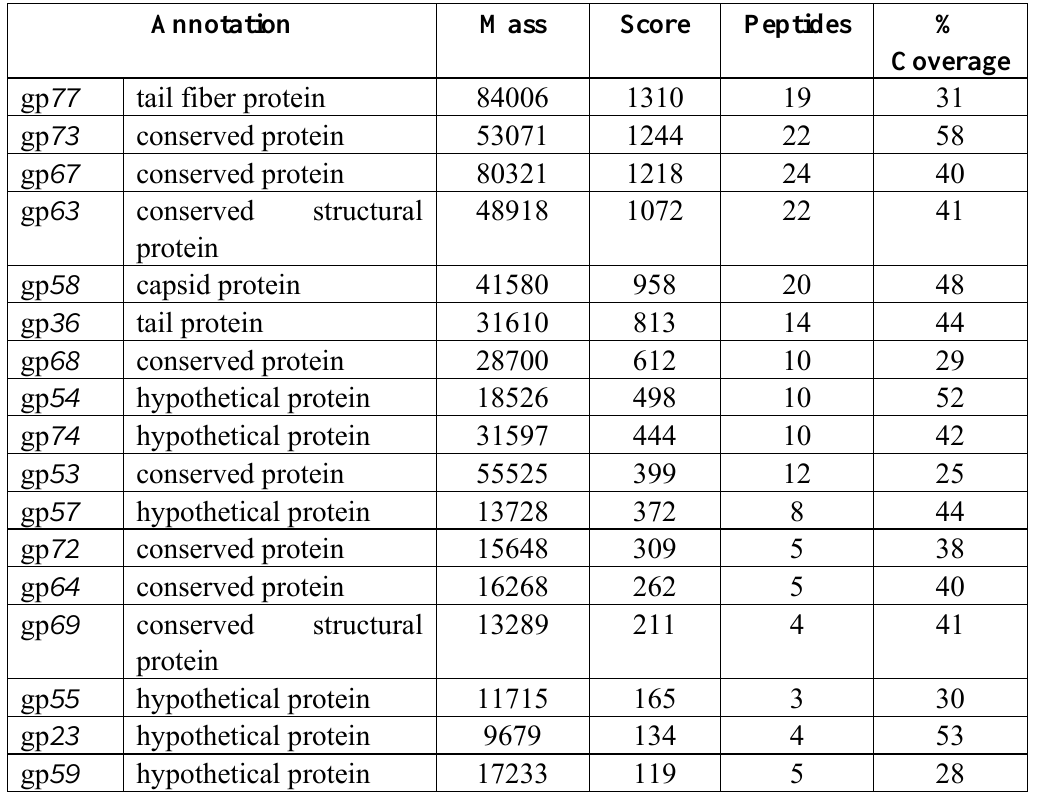
Table 4A. Bacteriophage Felix O1 proteins identified as a result of whole-phage shotgun analysis (WSA) using LTQ-FT LC MS/MS analysis and Mascot search against an in-house database. In order to minimize false positives only data for proteins in which coverage  25% are included though this eliminated two likely proteins (orf 76 , tail fiber protein GP37, 9% coverage; and, orf 71 , baseplate protein, 15% coverage). The top 17 proteins are presented (peptide score >40, mass accuracy <2ppm, false discovery rate <0.65).